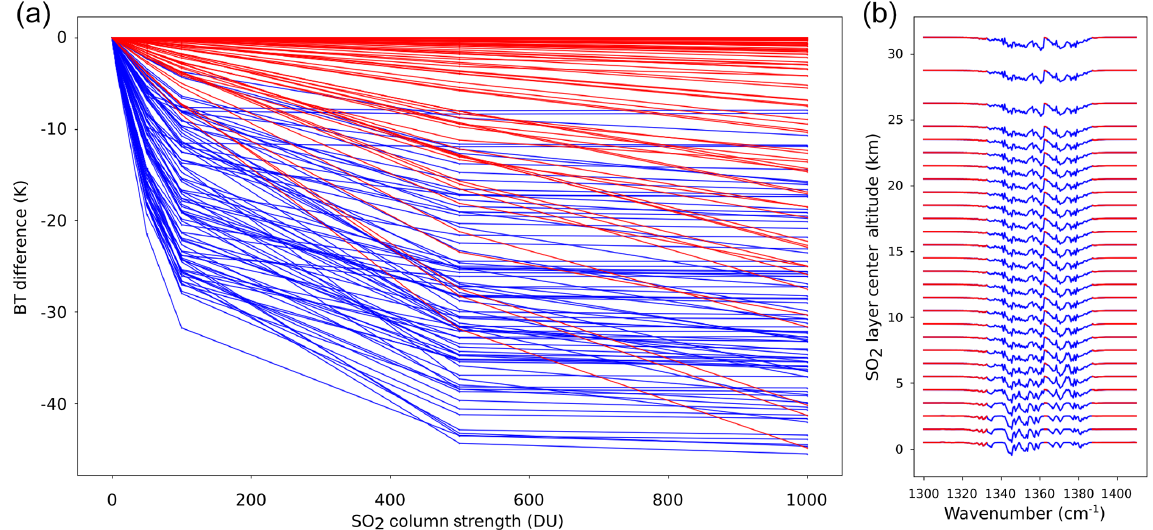
Figure 2. (a) Channel-wise brightness temperature difference response to increasing VCD. All channels here are used in the original retrieval. Red channels are used in the specialized retrieval due to their mostly linear response across the full range of reasonable VCD. (b) Height- dependent Jacobians (normalized) showing specialized channel selection in panel (a)